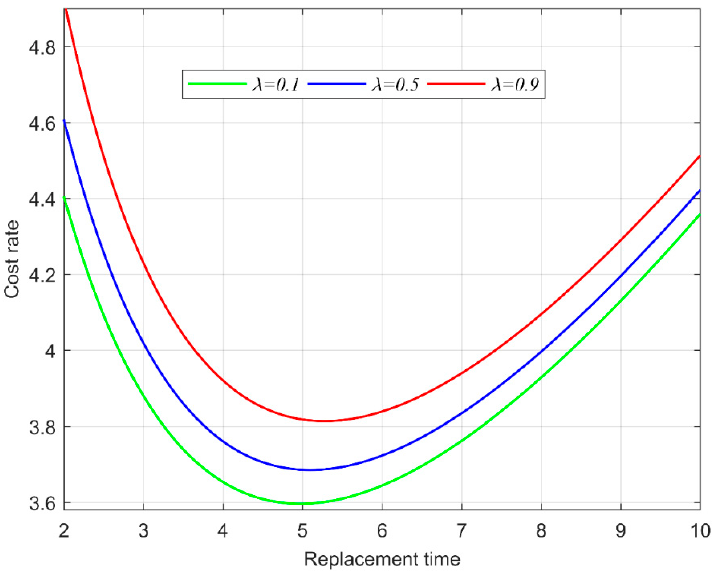
Figure 4. The effect of λ on the post-warranty maintenance policy.